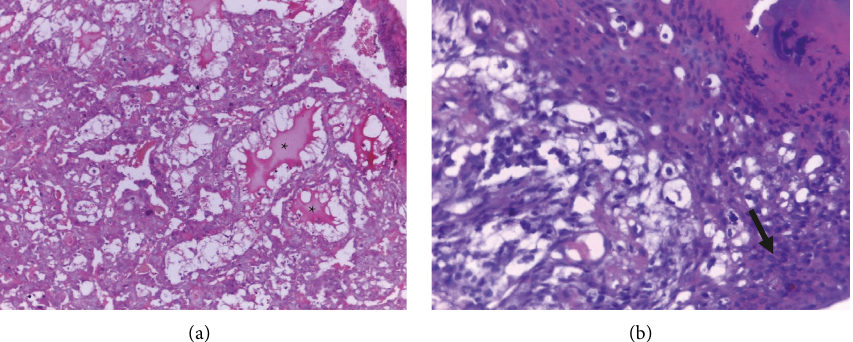
Figure 3: Photomicrograph of rat placenta (a & b) from a rat treated with 1000mg/kg of ethanol extract of S. guineense leaves (group III) showing decidual cystic degeneration ( ∗ ) and trophoblast proliferation (arrow); H and E stain, 200 × total magnification. Table 4: Microscopic placental abnormalities of rats following administration of 70% ethanol leaf extracts of Syzygium guineense . Percent of placental abnormalities Group Decidual cystic degeneration Hemorrhage/hematoma Trophoblast proliferation Group I (250mg/kg) 0 0 0 Group II (500mg/kg) 10 10 10 Group III (1000mg/kg) 20 0 10 Group IV (control) 10 10 0 Group V ( Ad libitum control) 0 0 0 Results are expressed as percentage of placental abnormalities,